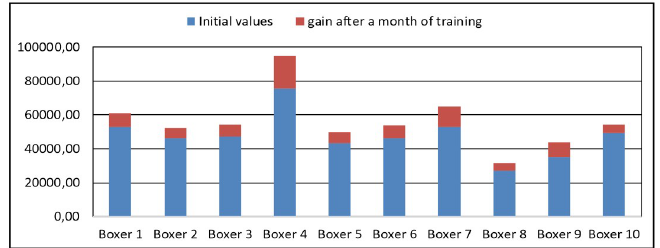
Fig 10. A graph of the punch quality, group